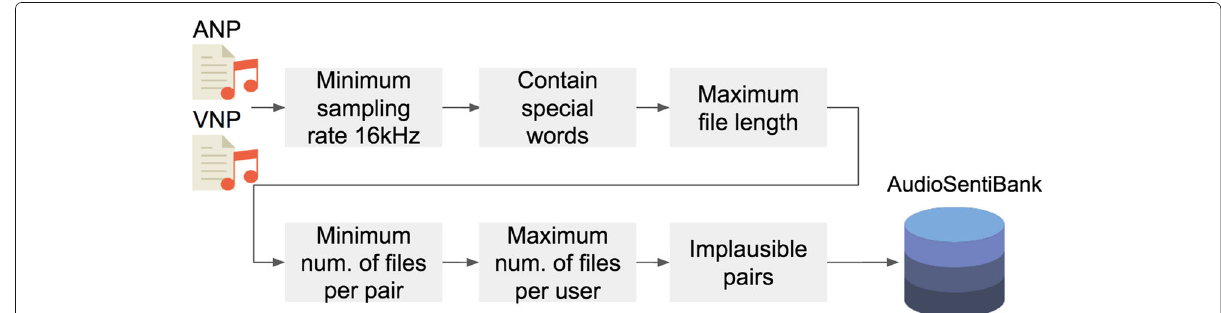
Fig. 2 Data filtering. The refining process consisted of six steps where pairs that did not meet a certain criterion were discarded. Steps 2,5 and 6 were responsible of the highest number of discarded